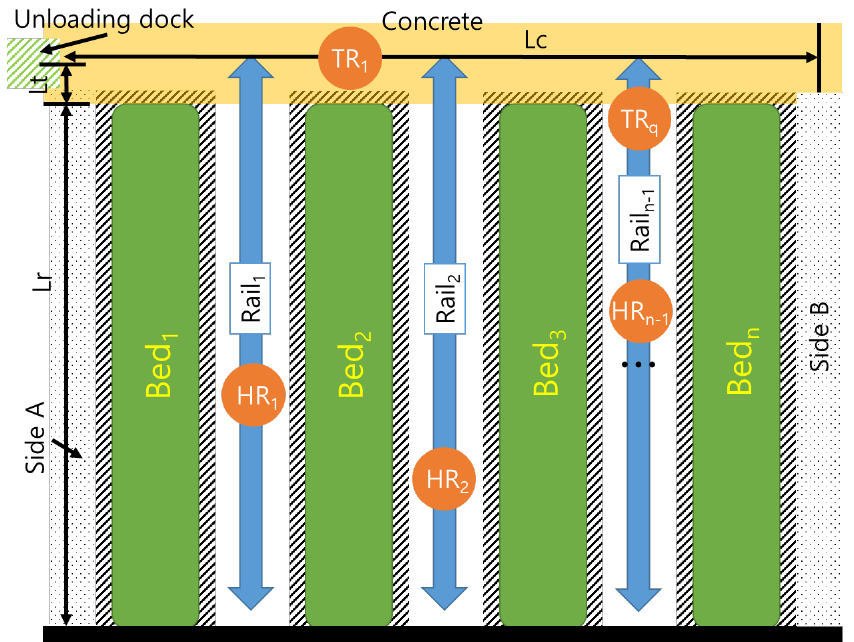
Figure 1. General structure of smart greenhouse.